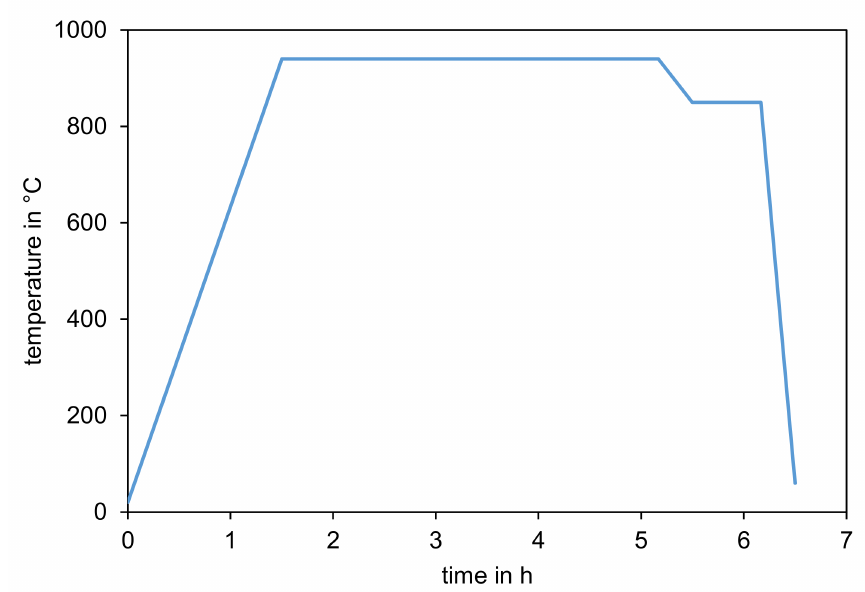
Figure 1. Schematic representation of the single-stage heat treatment process. The low-pressure carburising was carried out in a two-chamber system from Ipsen, Kleve, Germany, type RVFOQ, with integrated oil quenching. The batch chamber has the dimensions 400 × 300 × 220 mm 3 . The carburising medium used was 600 L/h acetylene at a pressure of 4 mbar; evacuation to approximate 5 × 10 − 2 mbar was applied during the dif- fusion phase. The programme used was composed of seven alternating carburising and dif- fusion steps (carburizing + diffusion: 2 + 20-1.5 + 30-1.5 + 30-1.5 + 30-1 + 30-1 + 40-1 + 40 in min). After carburising, the temperature was reduced to 850 ◦ C in 20 min, held for 40 min in vacuum and subsequently quenched with 10 bar nitrogen for 10 min at maximum fan speed in a cold